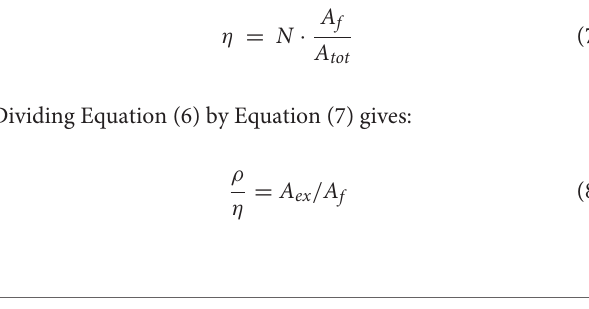
TABLE 3 | Values of the bending rigidity κ , the membrane coverage η , the fraction of the vesicles which are flat α f , the calculated adhesion energy k a , the area per MBP molecule A MBP and the adhesion energy per MBP molecule ǫ MBP .